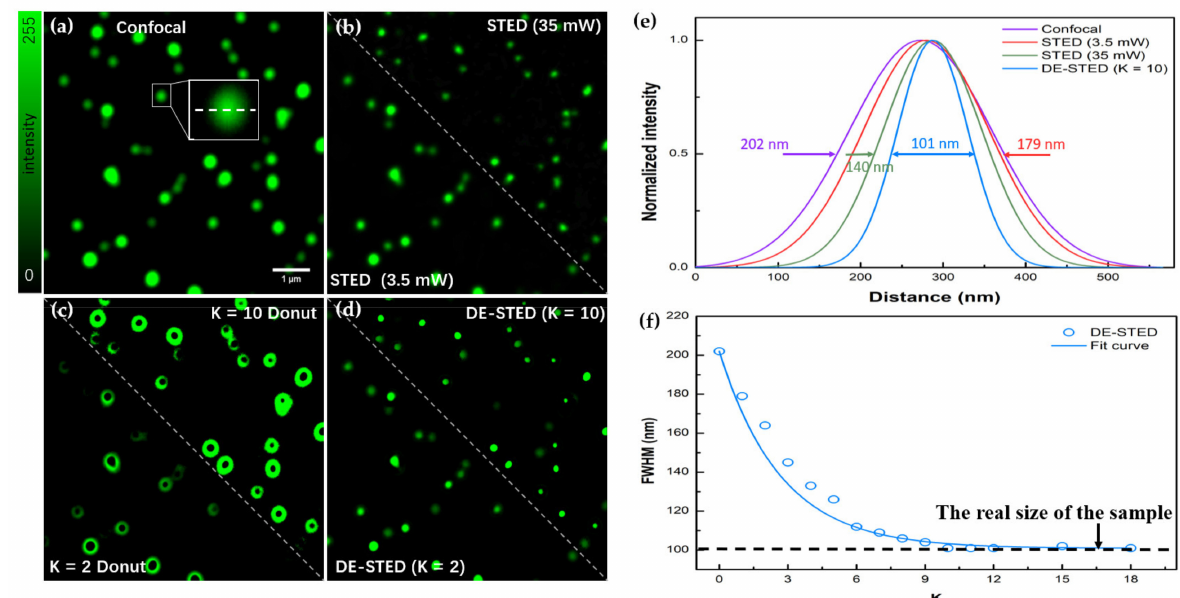
Figure 3. DE-STED imaging results for fluorescent beads on the lateral profile. ( a ) Confocal image. ( b ) STED image with depletion powers of 3.5 and 35 mW. ( c ) Donut image, where K = 2 and 10. ( d ) DE-STED results at K = 2 and 10. ( e ) FWHM curves for confocal, STED (3.5 and 35 mW), and K = 10 DE-STED, taking the marked fluorescent beads in ( a ) as the research object. ( f ) Curves of the relationship between the FWHM and the K value. Field of view (FOV): 7.43 µ m. Scale bar: 1 µ